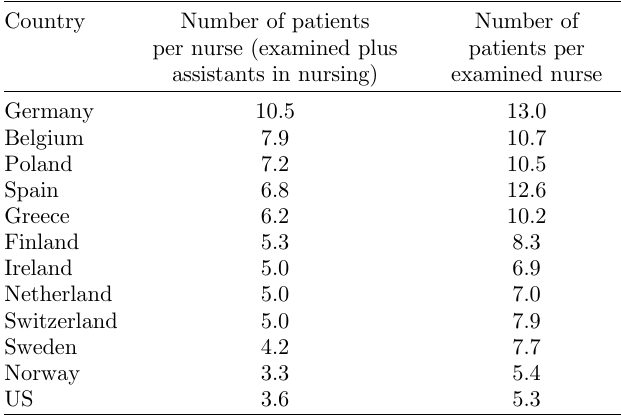
Table 4. Comparison of nurse staf fi ng of Germany with various European countries and the US according to